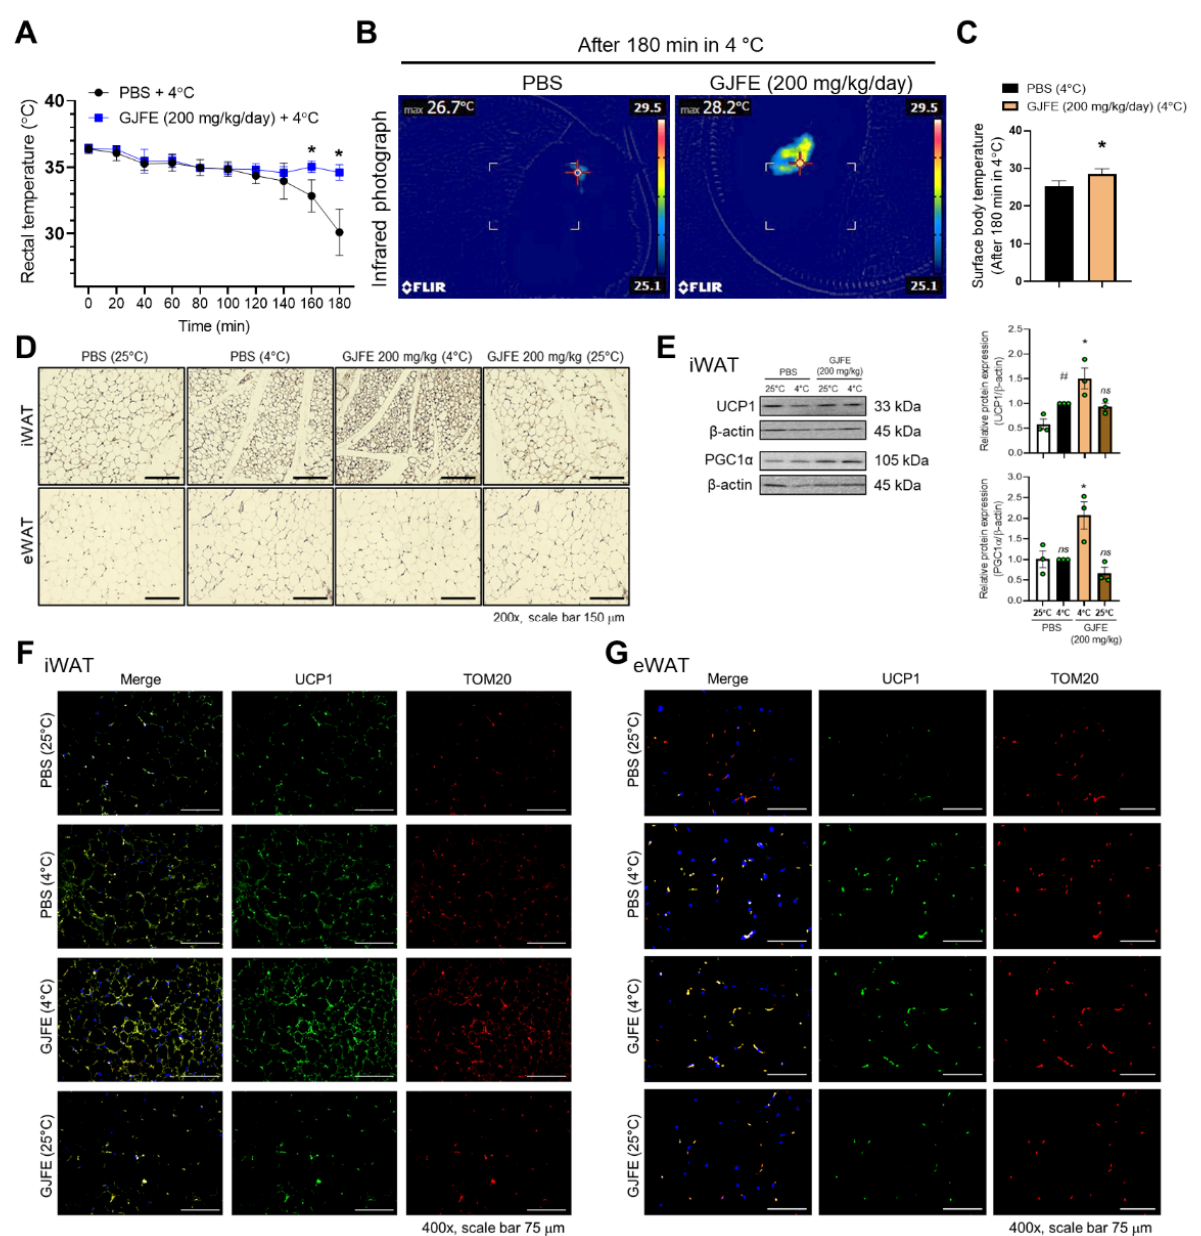
Figure 1. Effect of GJFE on non-shivering thermogenesis in cold-exposed C57BL/J mice. ( A ) Rectal temperature was measured at indicated time points in mice kept in 4 ◦ C or 25 ◦ C for 5 h. ( B ) A representative infrared thermal image and ( C ) average surface temperature are shown ( n = 5 per group). ( D ) Paraffin-embedded iWAT and eWAT were stained with H&E (magnification 200 × , scale bar 150 µ m). ( E ) Protein levels of UCP1 and PGC1 α were analyzed by Western blot analysis. The expression of UCP1 (green), TOM20 (red), and DAPI (blue) of ( F ) iWAT and ( G ) eWAT in cold-exposed mice were detected by immunofluorescence staining (magnification 400 × , scale bar 75 µ m). β -actin was used as a loading control for Western blot analysis. # p < 0.05 vs. PBS-fed mice kept in 25 ◦ C, * p < 0.05 vs. PBS-fed mice with cold exposure. ns, non-significant. GJFE, Gardenia jasminoides fruit extract.